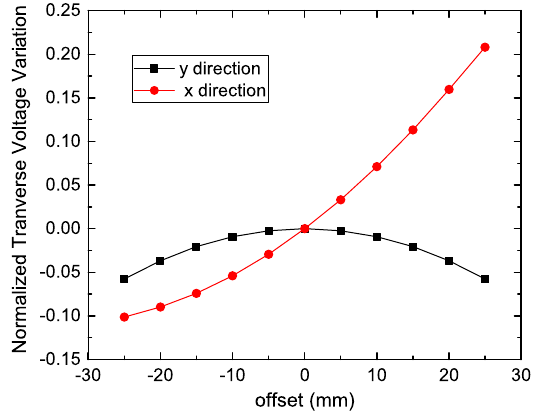
FIG. 13. Normalized transverse voltage variations in x any y direction, offset ¼ 0 is the beam line